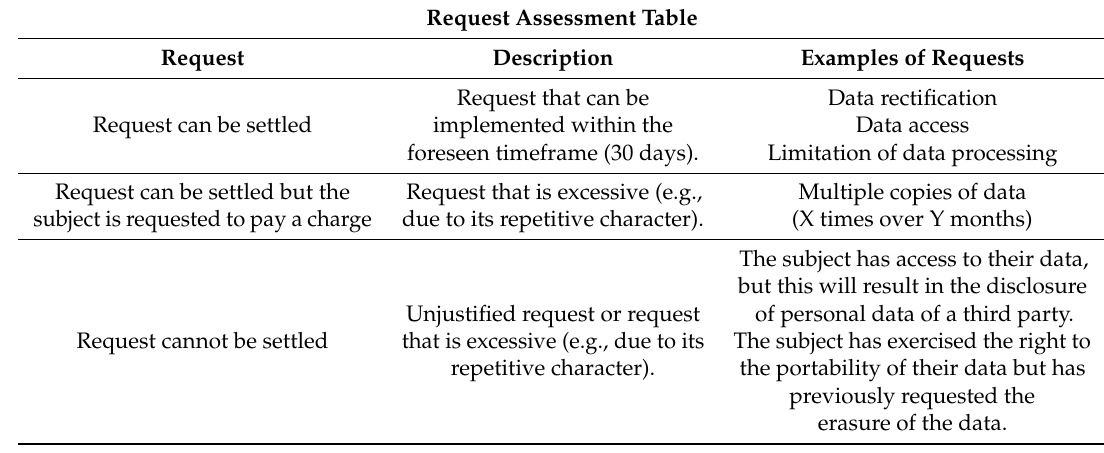
Table 3. Request assessment